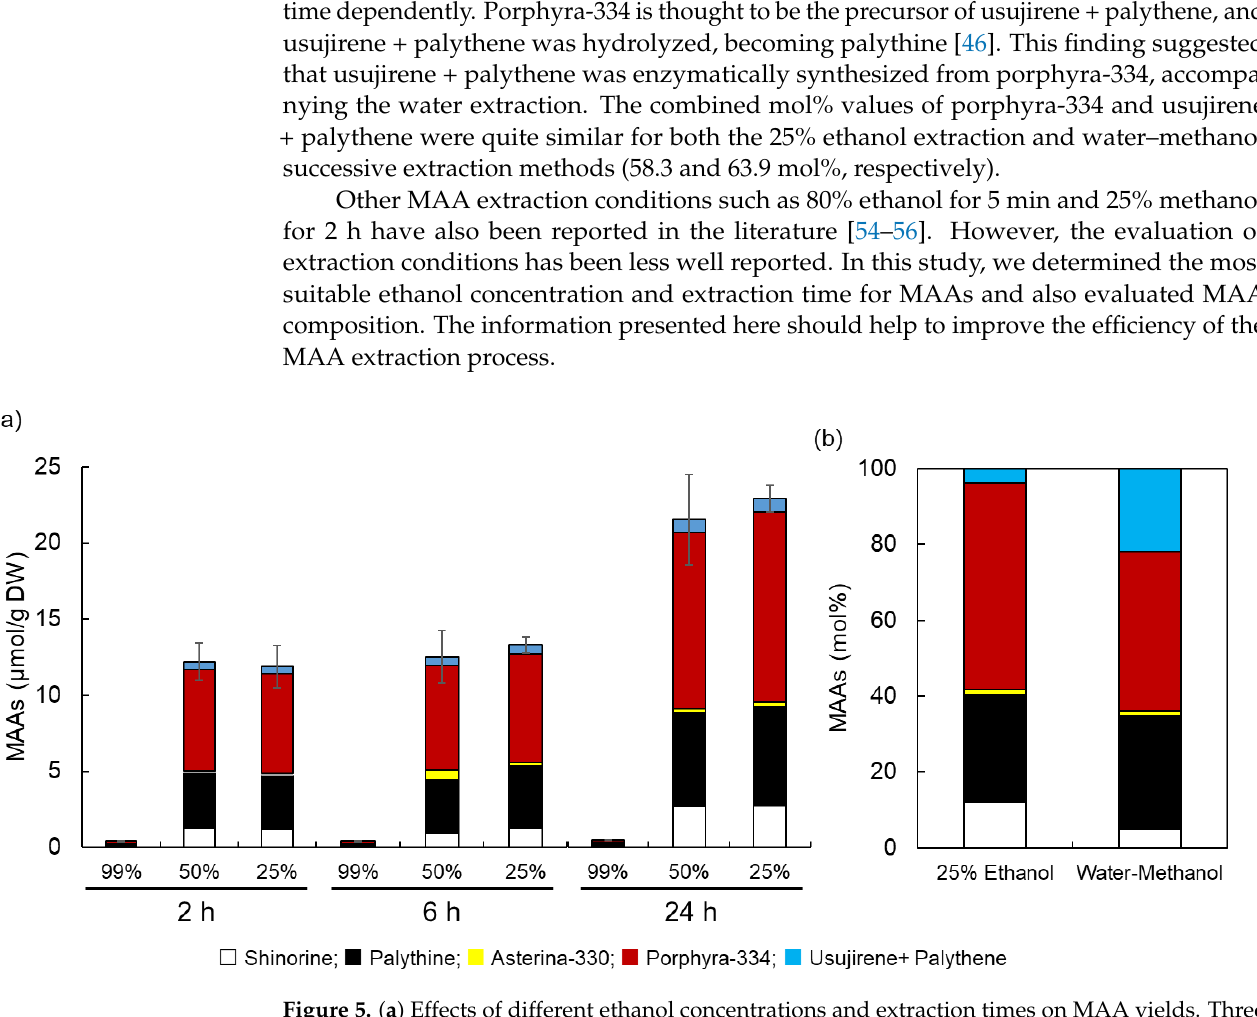
Figure 5. ( a ) Effects of different ethanol concentrations and extraction times on MAA yields. Three ethanol concentrations (25, 50, and 99%) and three extraction times (2, 6, and 24 h) were evaluated. Concentrations of each MAA were detected via HPLC. Error bars show the average of total MAAs ( n = 3). ( b ) Molar percentages of MAAs obtained using different extraction methods. Data were obtained from dulse collected on 25 March 2021. The data show mean values, n = 3. The values of 100 mol% in 25% ethanol and water –methanol successive extraction were 22.7 and 7.0 μmol/g DW, respectively.